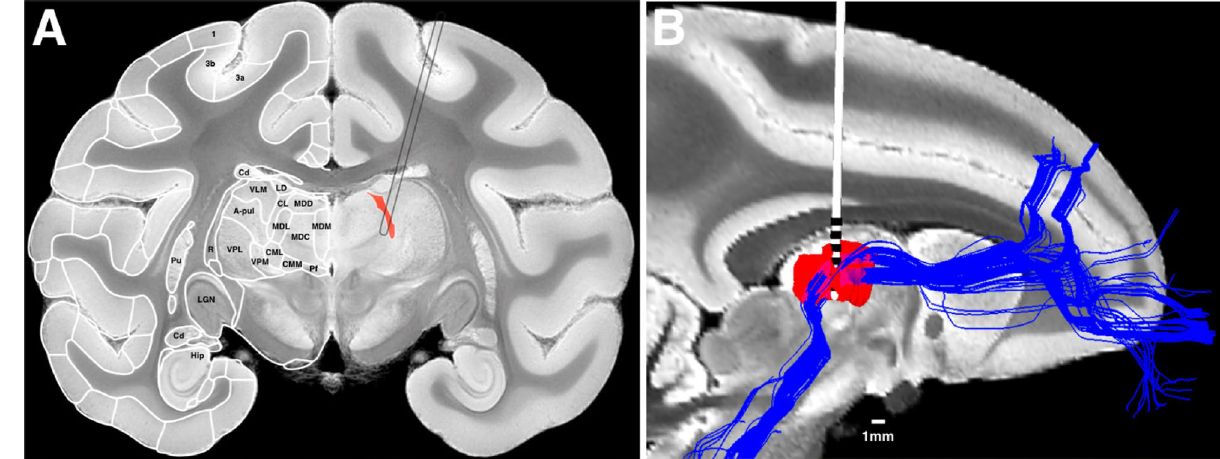
Figure 1. Targeting the central lateral (CL) nucleus and DTTm fiber pathway in healthy NHPs with scaled multi-contact DBS leads. ( A ) Coronal view of a gradient echo (GRE) image from the NHP MRI-DTI brain atlas used in this study (Calabrese et al., 2015) with cortical across consecutive trials 53 hemisphere. CL is colored in red in the right hemisphere and the schematic outline of the scaled DBS lead (0.84 mm OD) illustrates the trajectory used to target CL and the DTTm fiber pathway. Shown is image 83 (148), − 9.3 mm from the anterior commissure, which can be found here: https:// scala blebr ainat las. incf. org/ macaq ue/ CBCet al15. APUL—anterior pulvinar; CL—centrolateral thalamic nucleus; Cm-Pf—centromedian thalamic nucleus, lateral part; CM—centromedian thalamic nucleus, medial part; Hip—hippocampus; LGN—lateral geniculate nucleus; MDC—mediodorsal thalamic nucleus, central part; MDD—mediodorsal thalamic nucleus, dorsal part; MDL—mediodorsal thalamic nucleus, lateral part; MDM—mediodorsal thalamic nucleus, medial part; Pf—parafascicularus nucleus; Pu—putamen; R—reticular thalamic nucleus; VLM—ventral lateral thalamic nucleus, medial part; VPL—ventral posterolateral thalamic nucleus; VPM—ventral posteromedial thalamic nucleus; 1—area 1 of cortex (somatosensory); 3a—area 3a of cortex (somatosensory); 3b—area 3b of cortex (somatosensory). (B) Sagittal view of the T2 imaging used for surgical planning of DBS lead trajectories. Here one of the three six contact DBS leads (NuMed Inc.) implanted into the right thalamus of NHP3 is shown. The CL nucleus, shown in red, and the targeted fibers of the DTTm reconstructed from a high-resolution ex vivo dataset (see “Methods” section, Sani et al., 2019), shown in blue, illustrate the pathway of brainstem and anterior forebrain projections of fibers passing through and/or originating in the CL nucleus. The geometry of the CL nucleus spans ~ 5 mm A-P, 4 D-V, 1 mm M-L in the adult